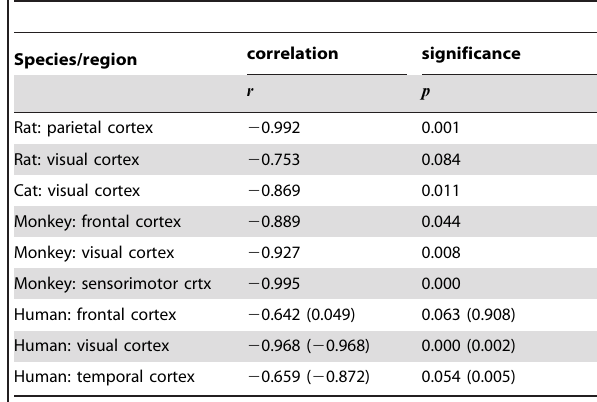
Table 5. Correlation between metabolic energy per synapse (CMR/ r ) and synaptic fraction of metabolism ( g ). s